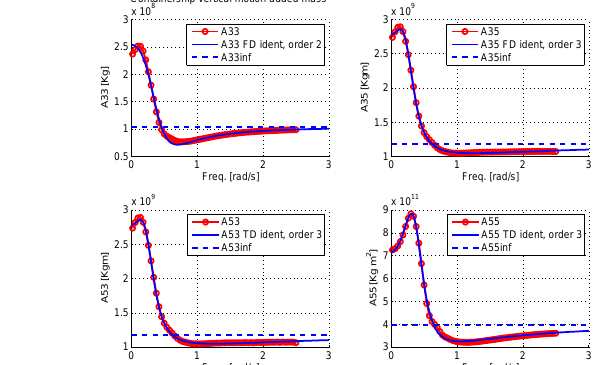
Figure 13: Reconstruction of added mass from the imaginary part of ˆ K 33 ( jω ) based on frequency-domain curve